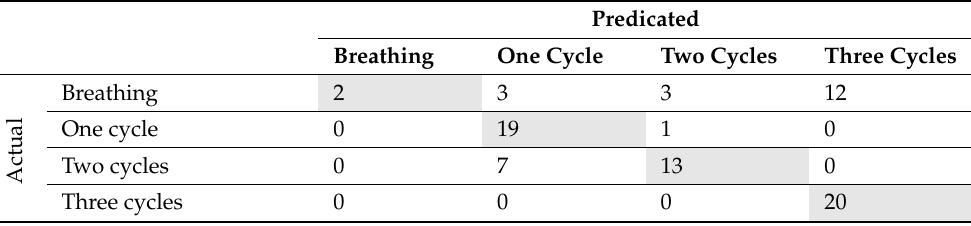
Table 6. Four-class confusion matrix for mouth movements. Rows represent actual class and columns represent predicted